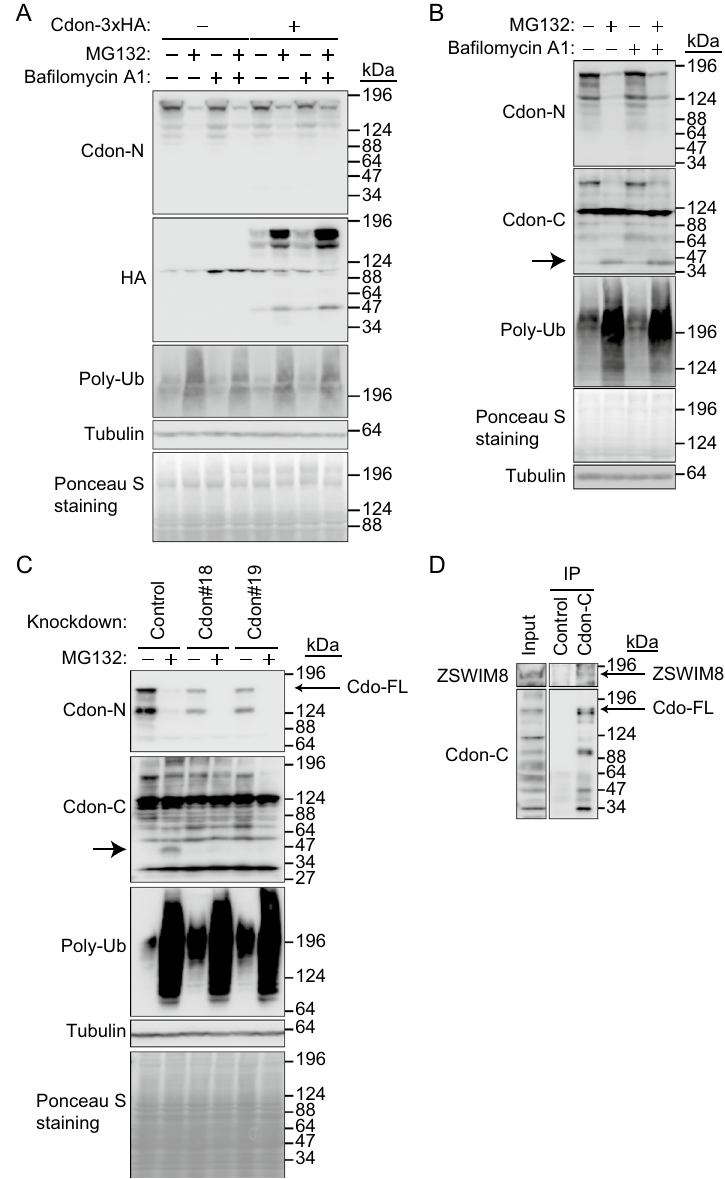
Figure 6. Downregulation of full-length Cdon by the proteasome inhibitor MG132 but not by the lysosome inhibitor bafilomycin A1. ( A ) Downregulation and accumulation of endogenous Cdon and Cdon-3HA, respectively, with the proteasome inhibitor MG132. Cdon-3 × HA was transiently expressed in C2C12 cells and cultured with or without MG132 (10 μM) and/or bafilomycin A1 (0.5 μM) for 7 h. The cell lysates were subjected to immunoblotting with an anti-Cdon-N, HA, or polyubiquitin (Poly-Ub) antibody. Tubulin and Ponceau S staining were used as loading controls. Representative data of three independent experiments. ( B ) Accumulation of Cdon fragment with MG132. C2C12 cells were cultured with or without MG132 (10 μM) and/ or bafilomycin A1 (0.5 μM) for 7 h. The cell lysates were subjected to immunoblotting with an anti-Cdon-N, Cdon-C, or Poly-Ub antibody. Tubulin and Ponceau S staining were used as loading controls. The MG132- dependent Cdon fragment is indicated by an arrow. Representative data of three independent experiments. ( C ) Downregulation of Cdon fragment by Cdon knockdown. Control or Cdon-knockdown (#18 or 19) C2C12 cells were cultured with or without MG132 (10 μM) for 7 h. The cell lysates were subjected to immunoblotting with an anti-Cdon-N, Cdon-C, Poly-Ub, or Tubulin antibody. Tubulin and Ponceau S staining were used as loading controls. The MG132-dependent Cdon fragment is indicated by an arrow. Representative data of three independent experiments. ( D ) Endogenous interaction between ZSWIM8 and Cdon. C2C12 cells were differentiated for 4 days. The cell lysates were subjected to immunoprecipitation with an anti-Cdon-C or control antibody and immunoblotted with an anti-ZSWIM8 or Cdon-C antibody. Representative data of two independent experiments. The membranes in ( A ) to ( D ) were cut prior to hybridization with antibodies. Full- length blots are presented in Supplementary Fig.